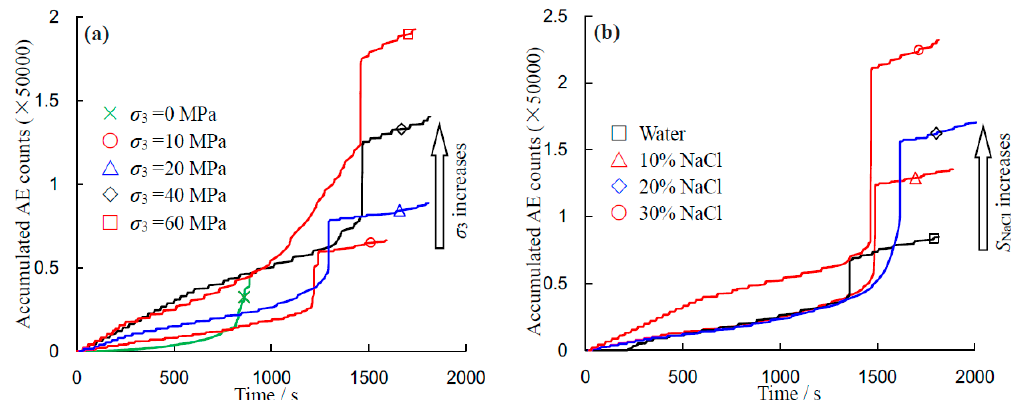
Figure 14. Effects of confining pressure and of salinity level on the accumulated AE counts of sandstone specimens under triaxial compression. ( a ) Influence of confining pressure (under 30% NaCl saturation); and ( b ) Influence of salinity level ( σ 3 = 40 MPa ).